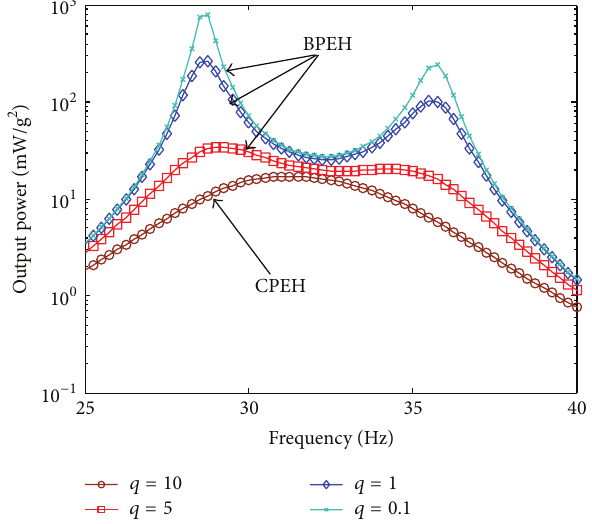
Figure 6: Tip relative velocity V 𝑠 with various 𝑎 when 𝑔 = 1 and 𝑅 L = 1k Ω .